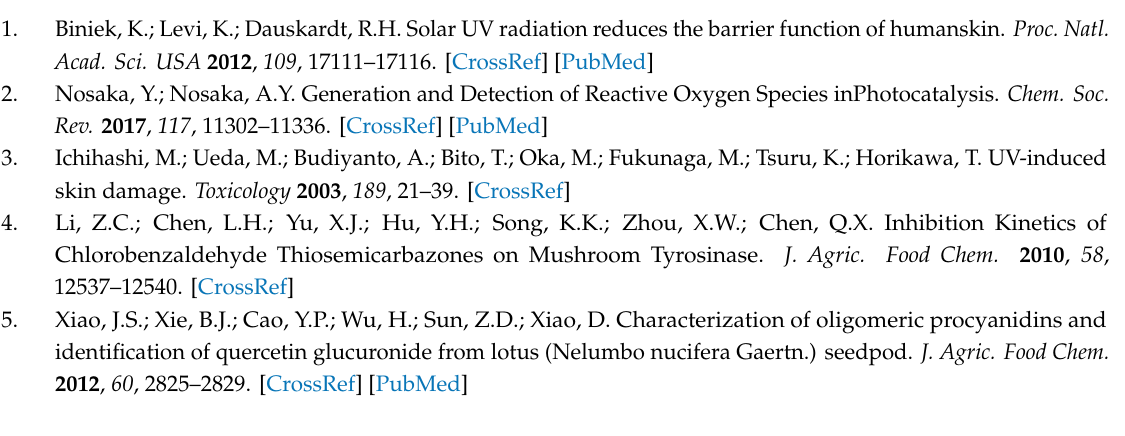
Supplementary Materials: The following are available online. Figure S1. GC chromatograms of chloroform and ethanol standard ( A ) chloroform:ethanol = 1:1; ( B ) chloroform:ethanol = 1:4; ( C ) LSOPC